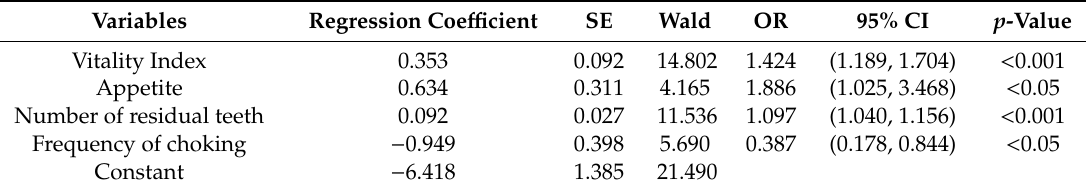
Table 5. Logistic regression